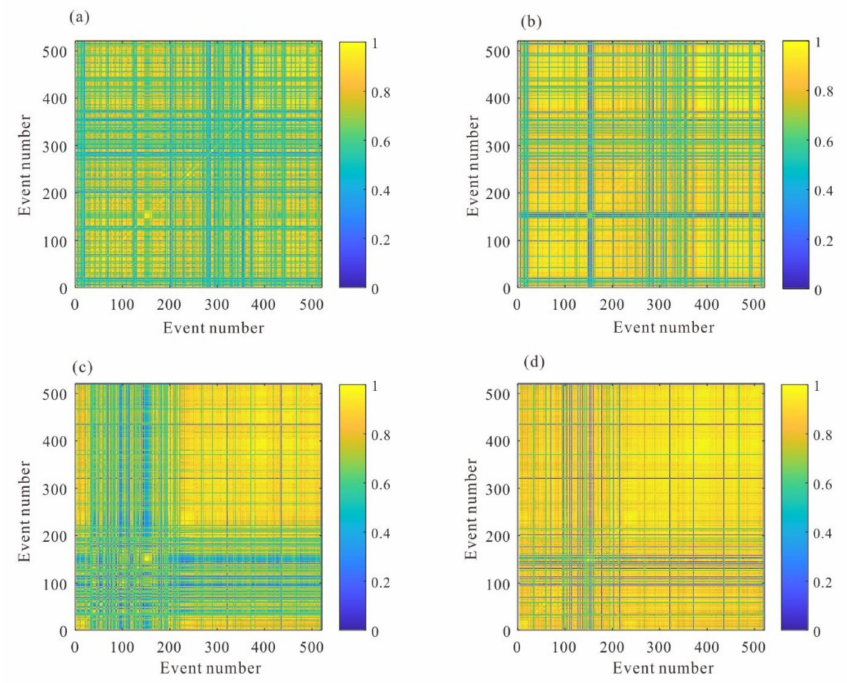
Figure 20. The similarity coefficients between the stacking waveforms before and after global optimization processing. ( a ) the similarity coefficients of the P wave before global optimization; ( b ) the similarity coefficients of the P wave after global optimization; ( c ) the similarity coefficients of the S wave before global optimization; ( d ) the similarity coefficients of the S wave after global